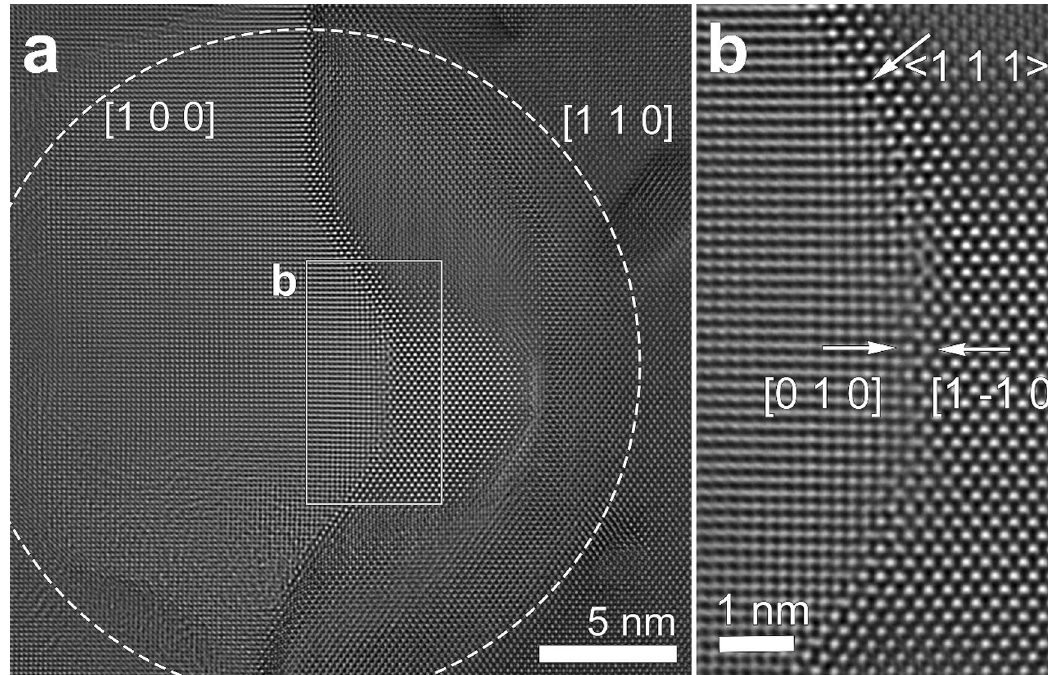
Figure 3. Sequential HRTEM images showing microstructural evolution of a GB region after beam irradiation with a beam diameter of 25 nm corresponding to a current density of ~ 815 A cm –2 for 3 min 38 s. ( a ) Low-magnification image showing GB migration from [1 0 0] to [1 1 0]. The irradiation diameter of 25 nm is marked by a dashed circle. ( b ) Enlarged image of the boxed region of ( a ), which shows that the region was faceted into atomically sharp (0 1 0)//(1 –1 0) and {1 1 1}